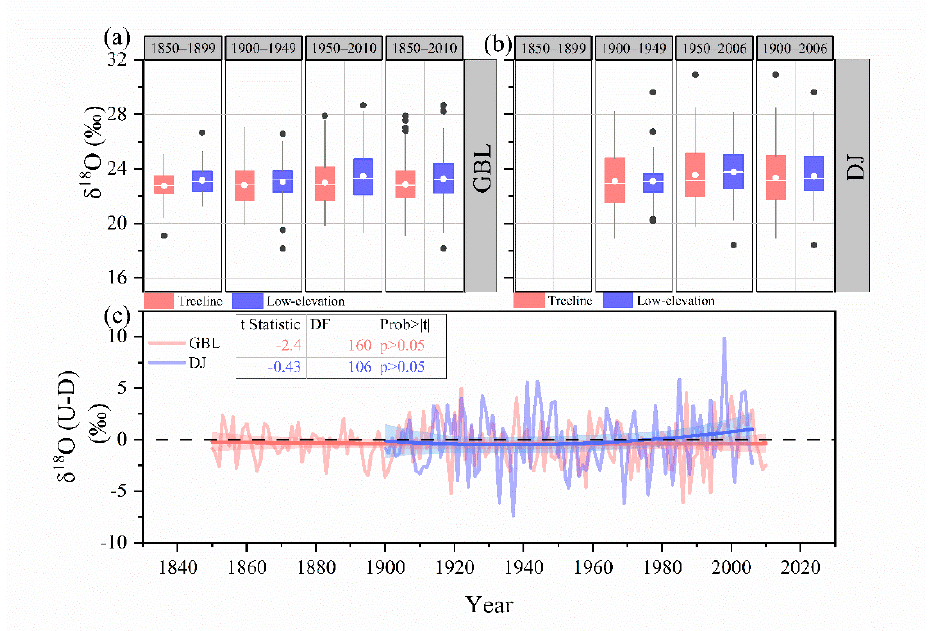
Figure 4. Comparisons of the mean values of tree-ring δ 18 O between the treeline (U) and low-elevation (D) plots for the two elevational transects GBL and DJ over different time periods ( a,b ), and ( c ) the difference (U-D) in BAI between treeline and low elevation. The black dots represent outliers as judged by more than 3 standard deviations departed from the mean values. The bold lines in ( c ) are regression lines and the shaded area denotes the 95% confidence intervals of the regressions.